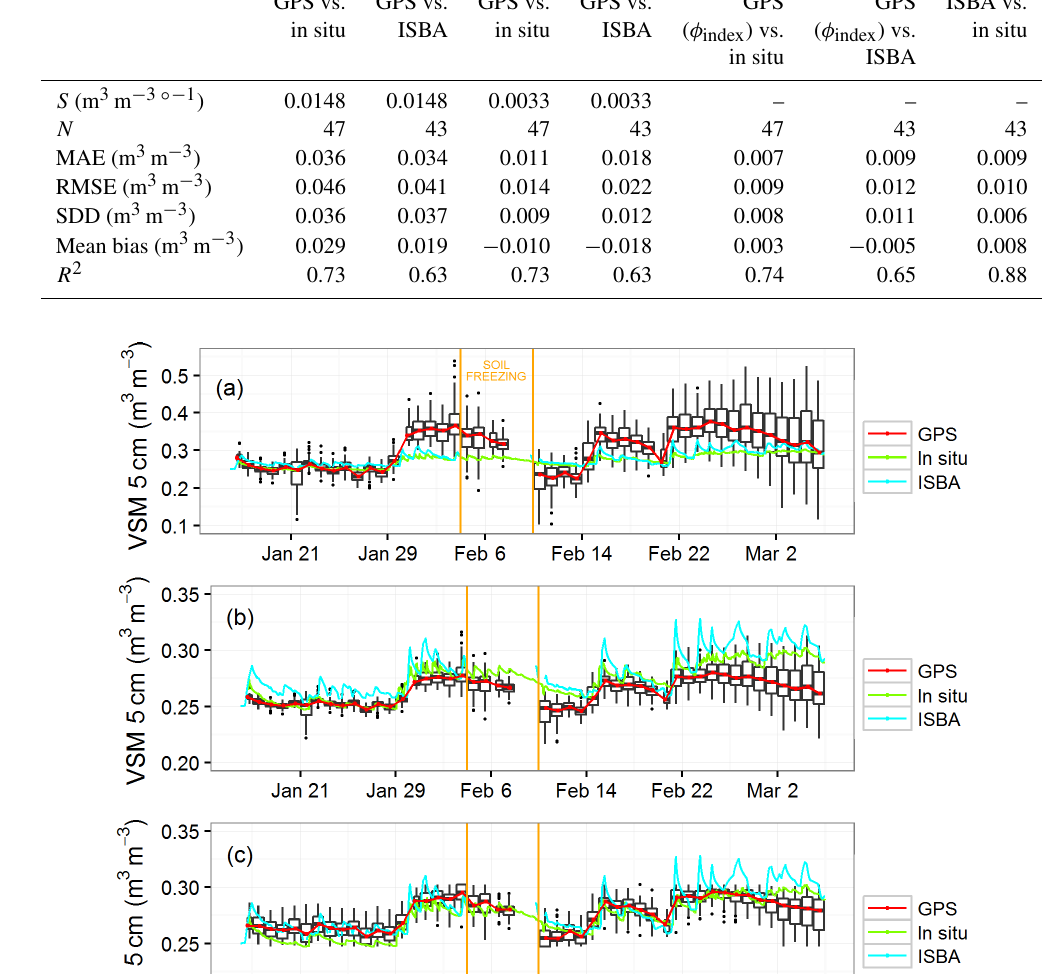
Table 1. Soil moisture scores from 16 January to 5 March 2015. MAE is the mean absolute error, RMSE is the root mean square error and SDD is the standard deviation of differences.